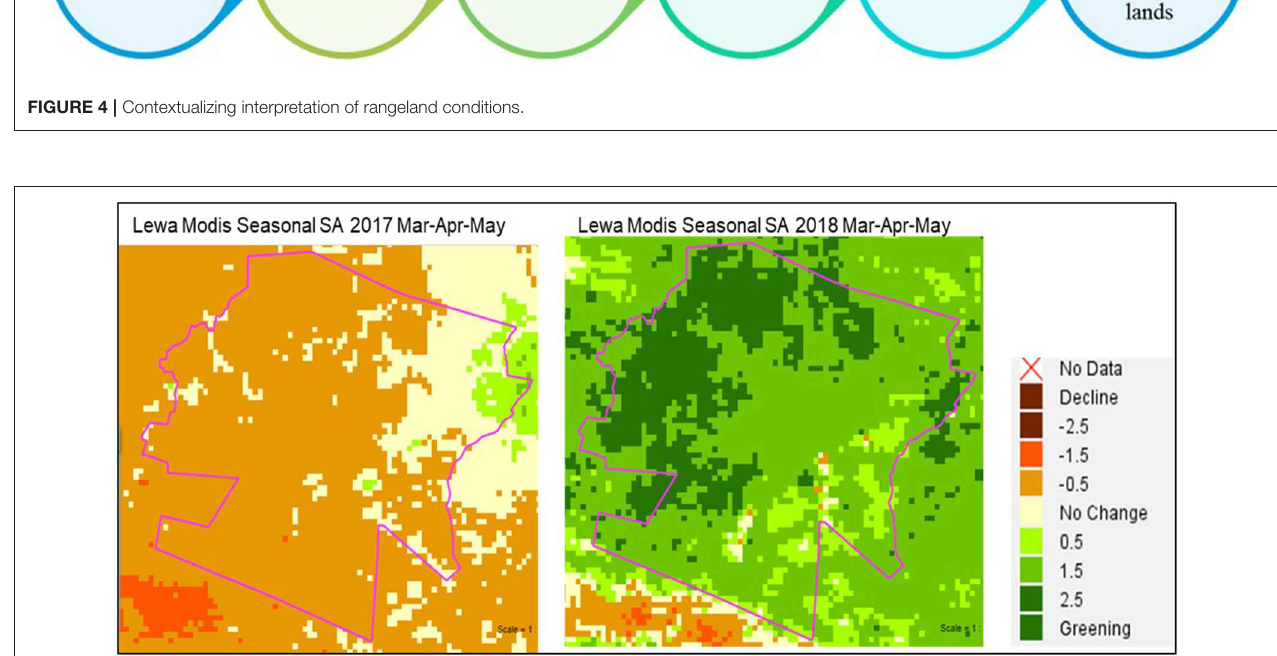
FIGURE 5 | Standardized anomalies for lewa conservancy during the 2017 and 2018 long rains